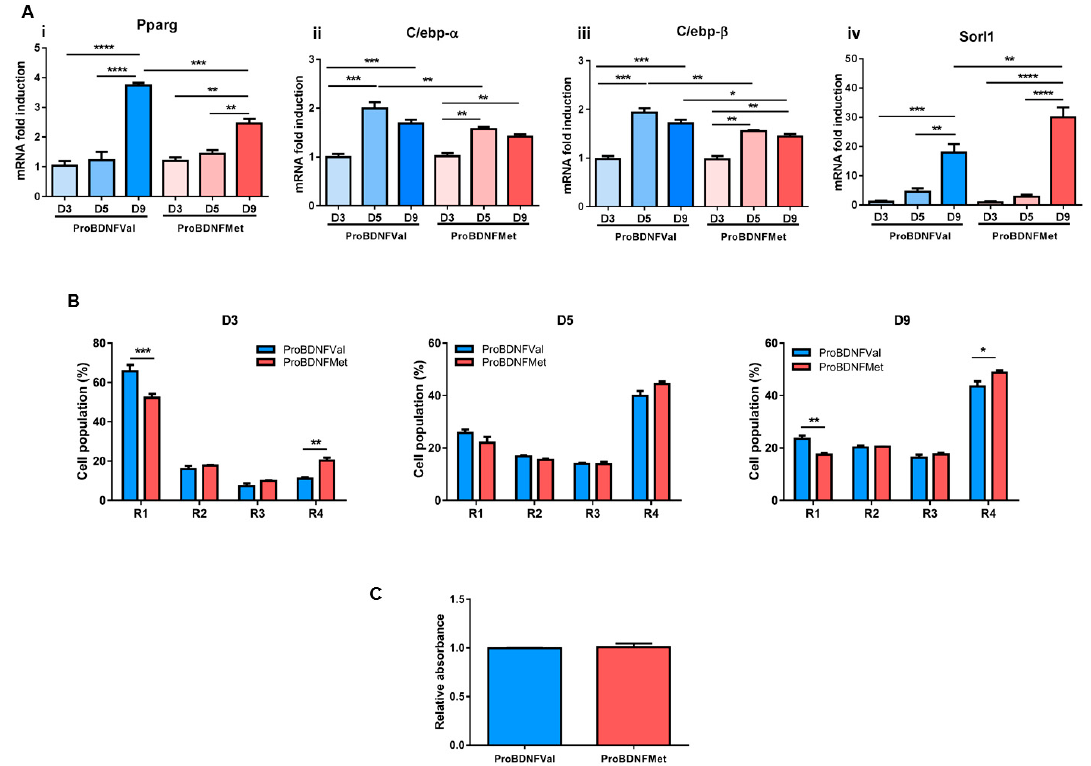
Figure 3. Effect of proBDNFMet on adipogenic differentiation of C3H10T1/2 cells. ( A ) mRNA levels of (i) Ppar γ , (ii) C/ebp- α , (iii) C/ebp- β , and (iv) Sorl1 . ( B ) Percentage of different cell populations based on their granularity profile analyzed by flow cytometry (R1: noninduced, R2-R3: growing granularity, and R4: high granularity) at day 3 (D3), day 5 (D5), and day 9 (D9) of differentiation, and ( C ) Oil-Red- O staining absorbance measurement in C3H10T1/2 cells. Data are expressed as mean ± SEM. n = 5 independent experiments/group. ( A ) Two-way ANOVA followed by Bonferroni post hoc analysis. ( B , C ) Student’s t-test. * p < 0.05, ** p < 0.01, *** p < 0.005, and **** p < 0.001.